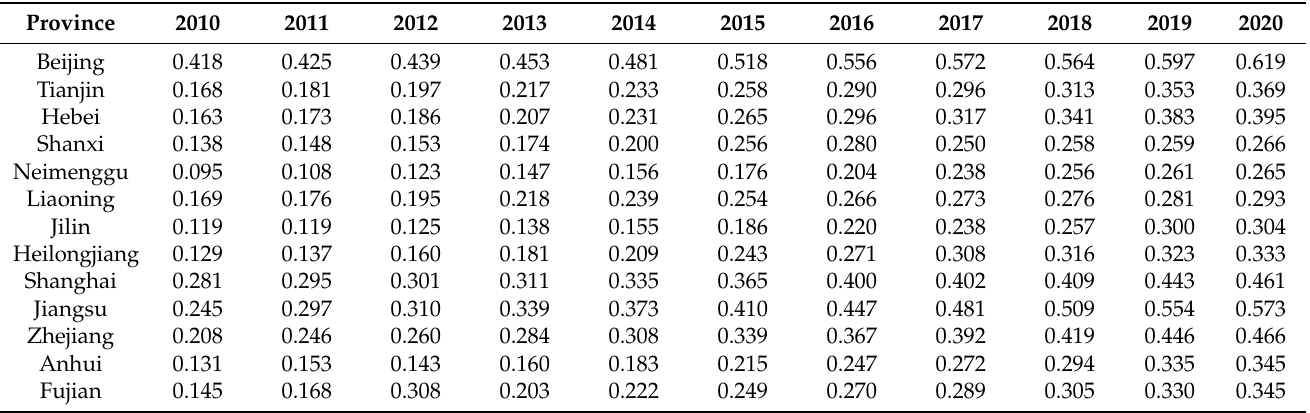
Table 3. Comprehensive evaluation results of energy utilization